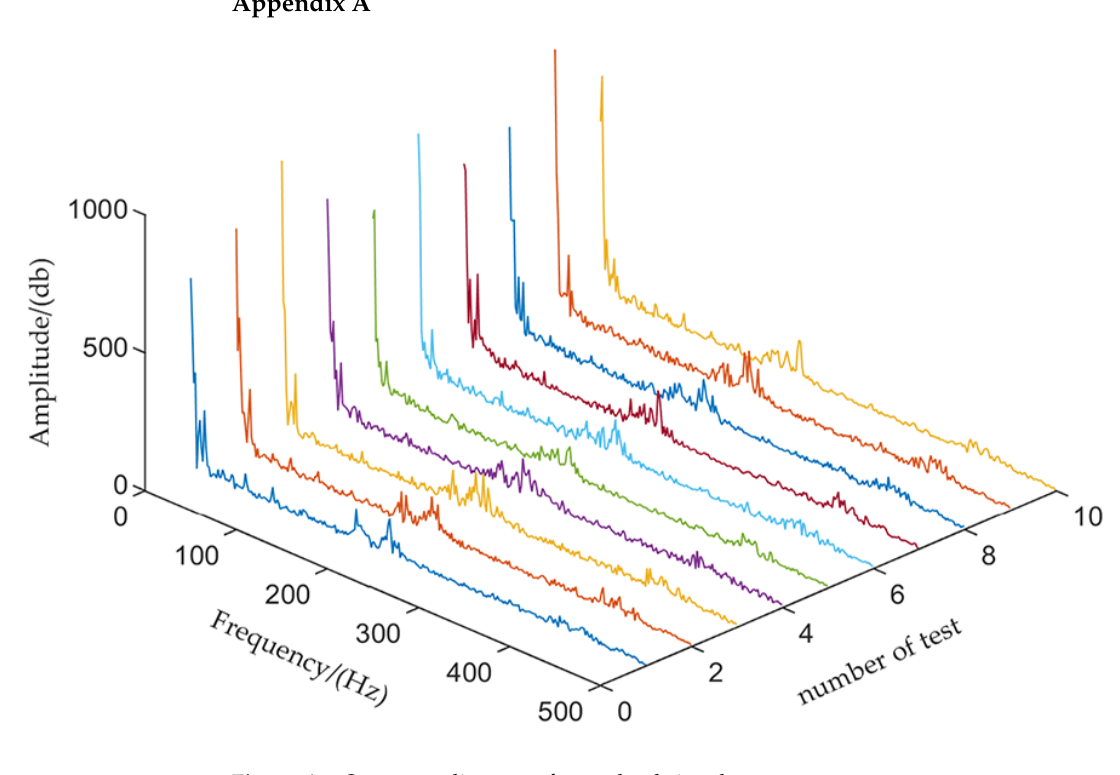
Figure A1. Spectrum diagram of non − load signal.